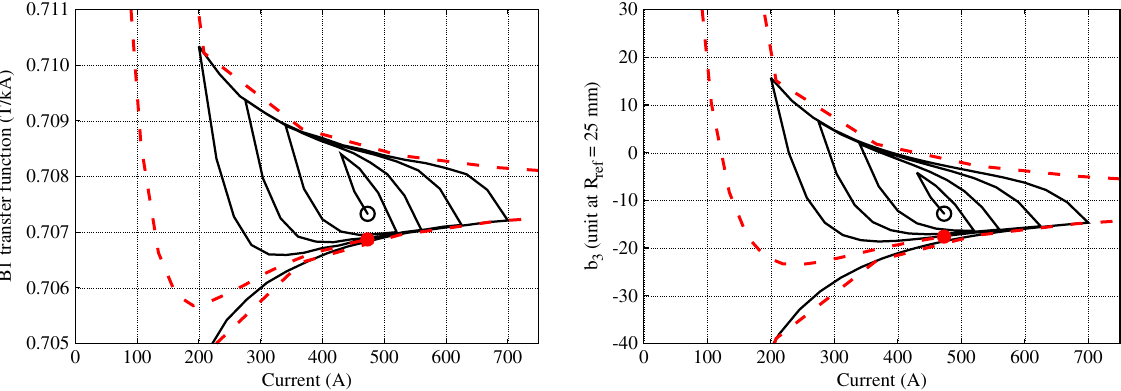
FIG. 3. The calculated dipole transfer function and normal sextupole component ( b 3 ) from the conventional cycle (red dashed line) and the demagnetization cycle (black solid line). The points denote the resulting values at the end of each cycle. R